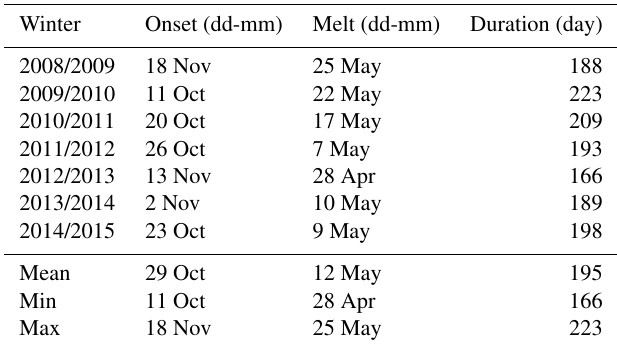
Table 3. Timing and duration of the seasonal snowpack at the bore- hole site derived from the ground surface temperature recorded over the 2008–2014